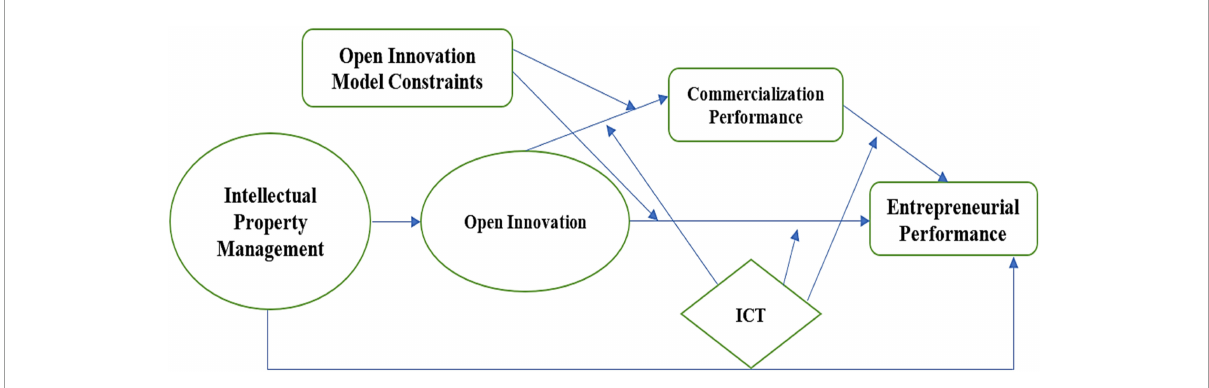
FIGURE1 Research model. IPM, Intellectual Property Management; OI, Open Innovation; CP, Commercialization Performance; ICT, Information Communication Technology; EP, Entrepreneurial Performance; OIMC, Open Innovation Model